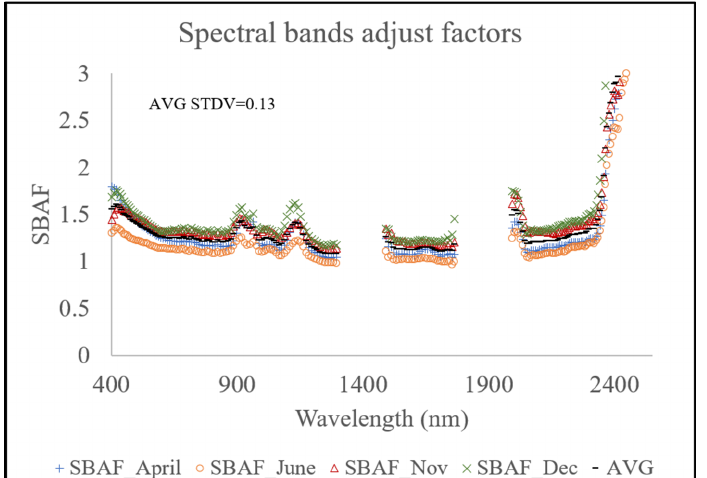
Figure 12. The spectral band adjustment factors (SBAFs) for PRISMA in different acquisition months (April—blue; June—orange; November—red; December—green; average SBAF—black). To validate the concept of this method, we applied the November AP SBAF on the original PRISMA AP image. Figure 13 shows the result for the November image: the original PRISMA L2D (before calibration) signal (black line) against the calibrated SBAF (blue line), and the ground-truth ASD (dashed red line). The artifacts in the VNIR bands (900–1000 nm) were removed, and the absorbance at 2340 nm (carbonates) was better obtained in the PRISMA signal after the calibration. The RMSE of the calibrated November signal against the ASD reflectance was 0.05 vs. the original (L2D product before calibration) 0.15. The total σ uncertainty for the model was calculated from Equations (7)–(9), where n is 220, the number of wavelengths used for the cross-calibration; A is PRISMA (sensor to be calibrated); M is AisaFENIX (well-calibrated sensor); and ph is ASD, and was 0.06. (cid:112) σ 2 Spatial + σ 2 calibration Uncertainty total σ = (cid:113) = Spatial [( PRISMA ( 0.015 ) 2 + ASD ( 0.020 ) 2 + AISA ( 0.023 ) 2 )] + calibration ( 0.05 ) 2 =